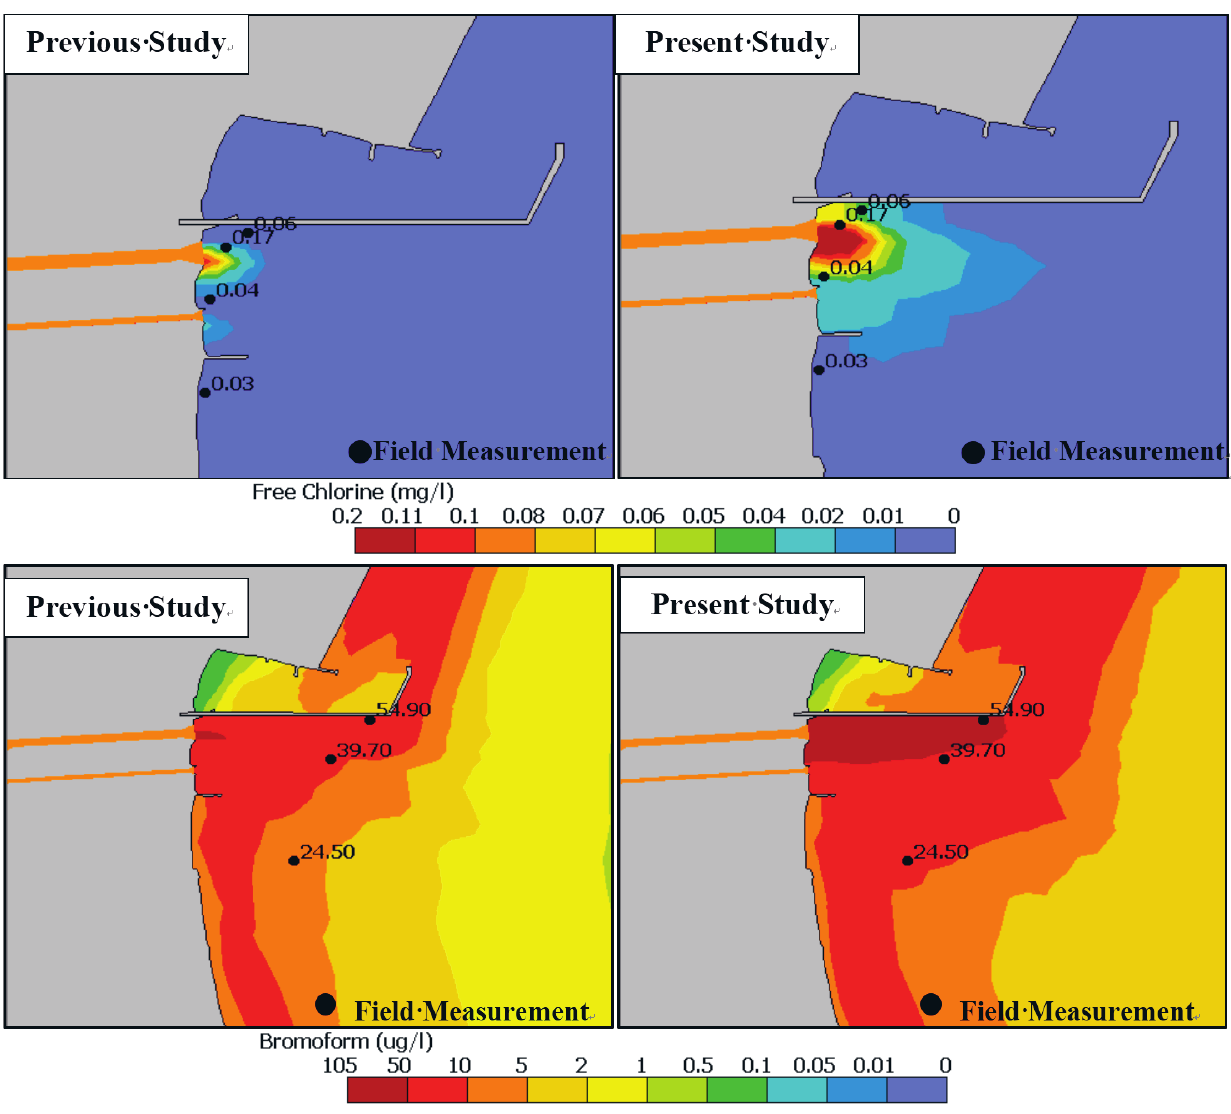
Figure 9. Correlation between laboratory measurements and multivariate regression-predicted bromoform formation at different chlorine dosages for all temperature